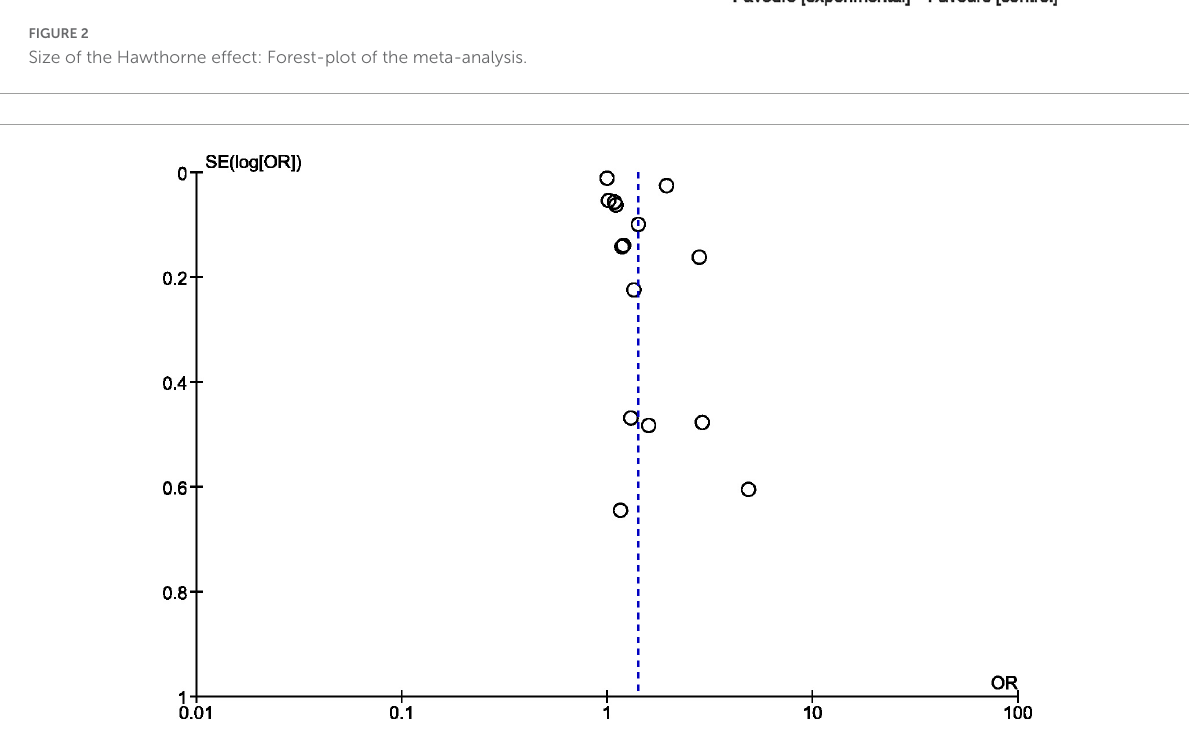
FIGURE3 Funnel-plot of reports included in the